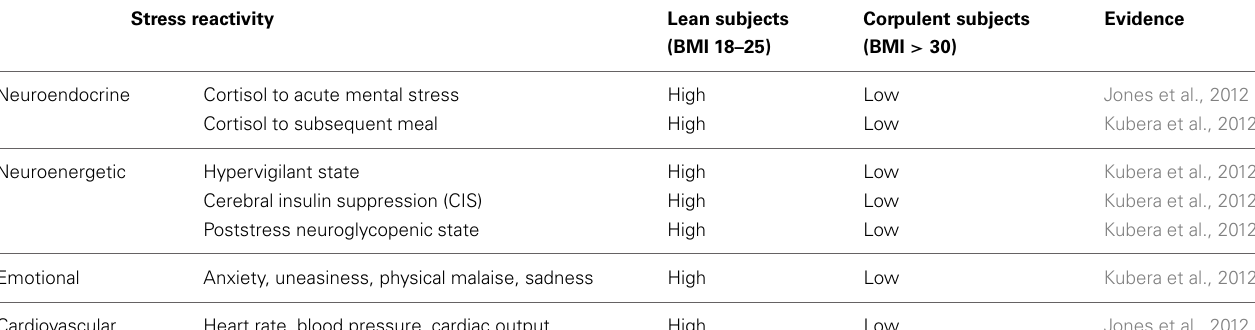
Table 1 | Differential stress reactivity in lean and corpulent subjects.